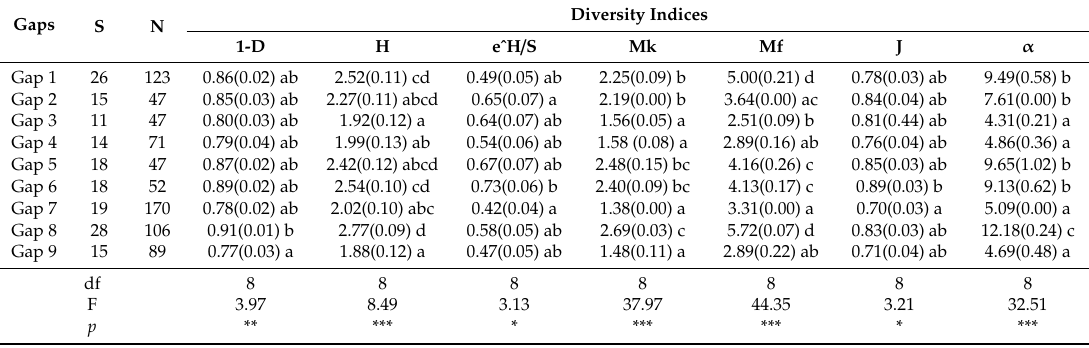
Table 2. Various biodiversity indices comprising Taxa (S), Individuals (N), Simpson’s index (1-D), Shannon diversity index (H), Evenness index (eˆH / S), Menhinick’s richness (Mk), Margalef (Mf), Equitability (J) and Fisher alpha ( α ) presenting species diversity of gap regeneration at Bia Tano Forest Reserve of Ghana. Mean values with corresponding standard errors in parentheses are presented.